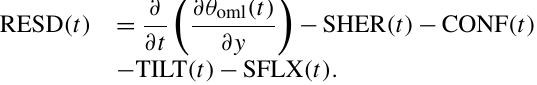
Figure 3. Annual-mean climatological states of OML-mean hori- zontal current (arrows) and vertical velocity at the bottom of the OML